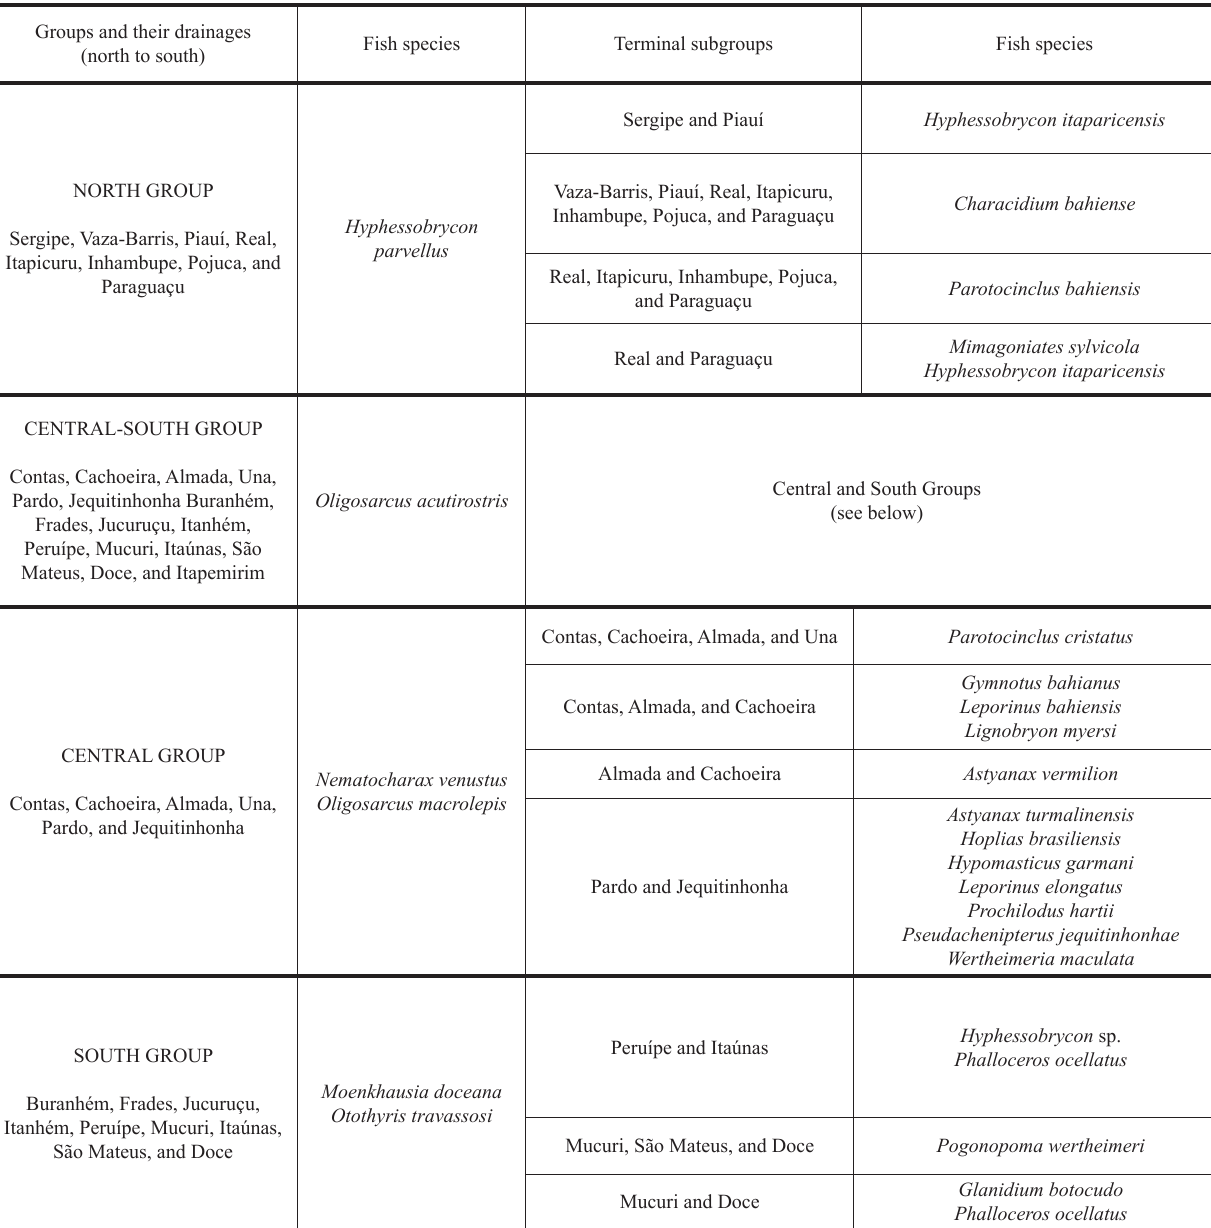
Table 3. Biogeographic groups of drainages of Northeastern Mata Atlântica freshwater ecoregion and the species used to support them, as determined by parsimony analysis of